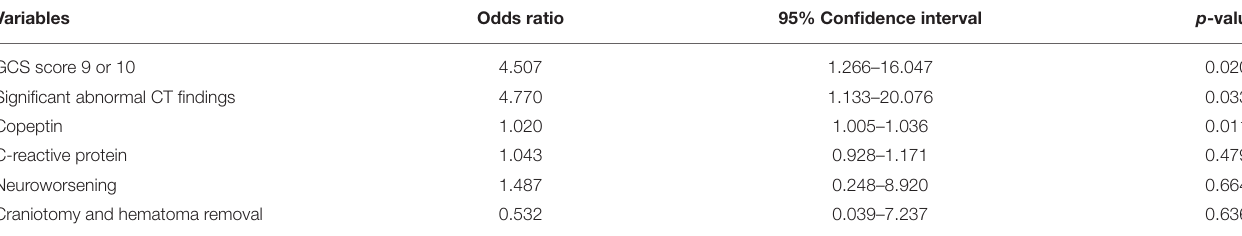
TABLE 2 | Multivariable logistic regression analysis for 6-month poor outcome in patients with moderate TBI. Variables